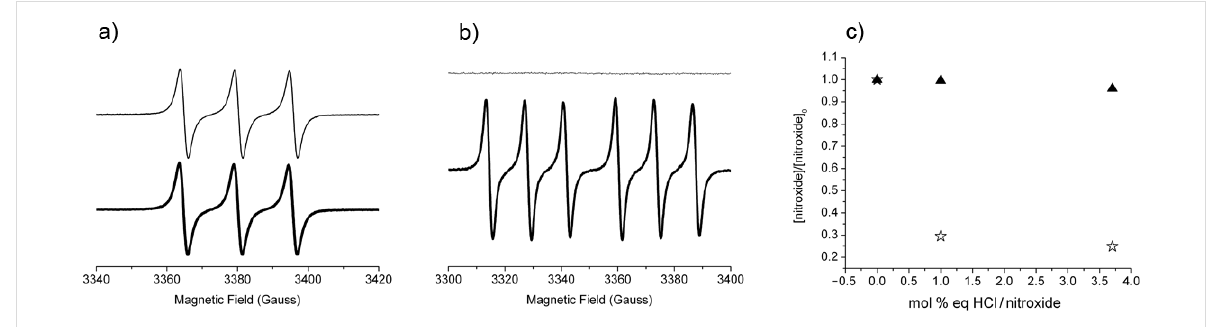
Figure 12: Degradation of the nitroxides (SG1 and TEMPO) in the presence of HCl. (a) TEMPO ESR signal in the presence of 3.7 mol % equivalents of HCl at t = 0 (thick line) and t = 5 h (thin line). (b) SG1 ESR signal in the presence of 3.7 mol % equivalents of HCl at t = 0 (thick line) and t = 5 h (thin line). c) SG1 (filled triangles) and TEMPO (empty stars) initial degradation ( t = 0) in the presence of 0, 1 and 3.7 mol % equivalent of HCl versus nitroxide (ESR in t -BuPh at 25 °C, samples heated at 120 °C in MeOH, and diluted in t -BuPh).